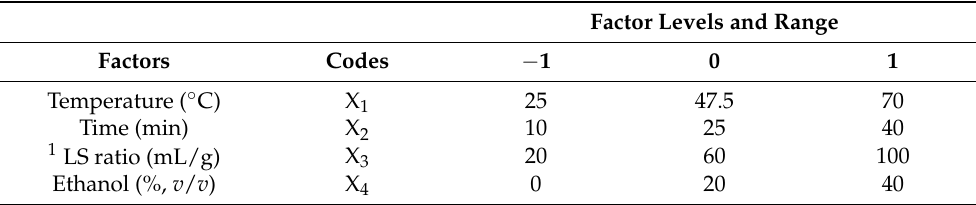
Table 1. Independent factors and their levels in the Box–Behnken Experimental Design. Factor Levels and Range Factors Codes − 1 0 1 Temperature ( ◦ C) X 1 25 47.5 70 Time (min) X 2 Ethanol (%, v / v